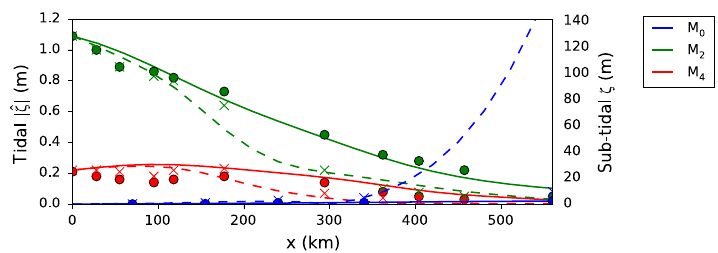
Figure 8. Water level amplitude for the Yangtze case when the computation of the reference level is omitted. The figure shows results for a dry season situation (solid line and dots) and a wet season situation (dashed line and crosses); see Fig. 7 for more explanation. Omitting the reference level leads to unrealistically high modelled sub-tidal water levels in the wet